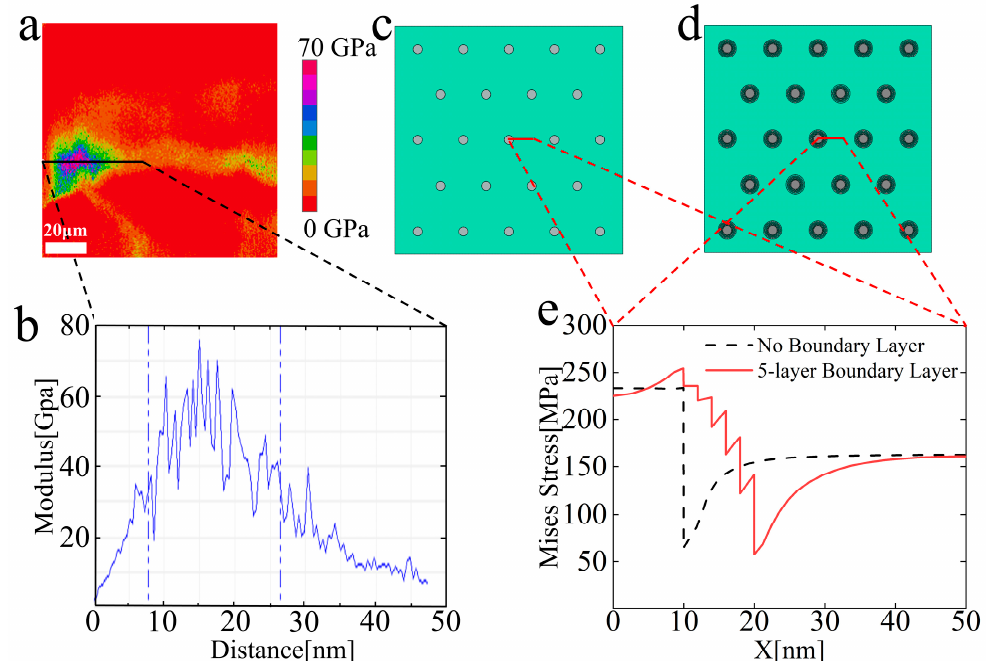
Figure 7. Results of the modulus mapping and finite element analysis. ( a ) A representative modulus map of the particle–matrix interfacial region of the composite; ( b ) Representative modulus profile of a scanning line shown in ( a ), showing the gradient variations of the modulus at the particle–matrix interfaces; ( c ) Finite element model without gradient boundary layers at the interfaces; ( d ) Finite element model with gradient boundary layers at the particle–matrix interfaces; ( e ) Distribution of the Mises stress at the interfacial region after loading.